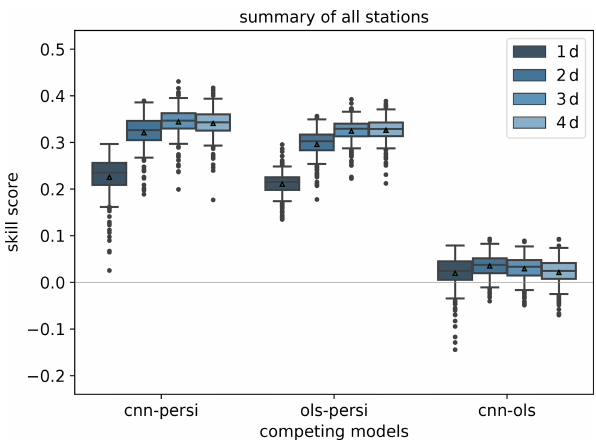
Figure 4. Skill scores of the IntelliO3-ts (cnn) versus the two ref- erence models’ persistence (persi) and ordinary least square (ols) based on the mean squared error; separated for all lead times (1d (dark blue) to 4d (light blue)). Positive values denote that the first mentioned prediction model performs better than the reference model (mentioned as second). The triangles denote the arithmetic means.